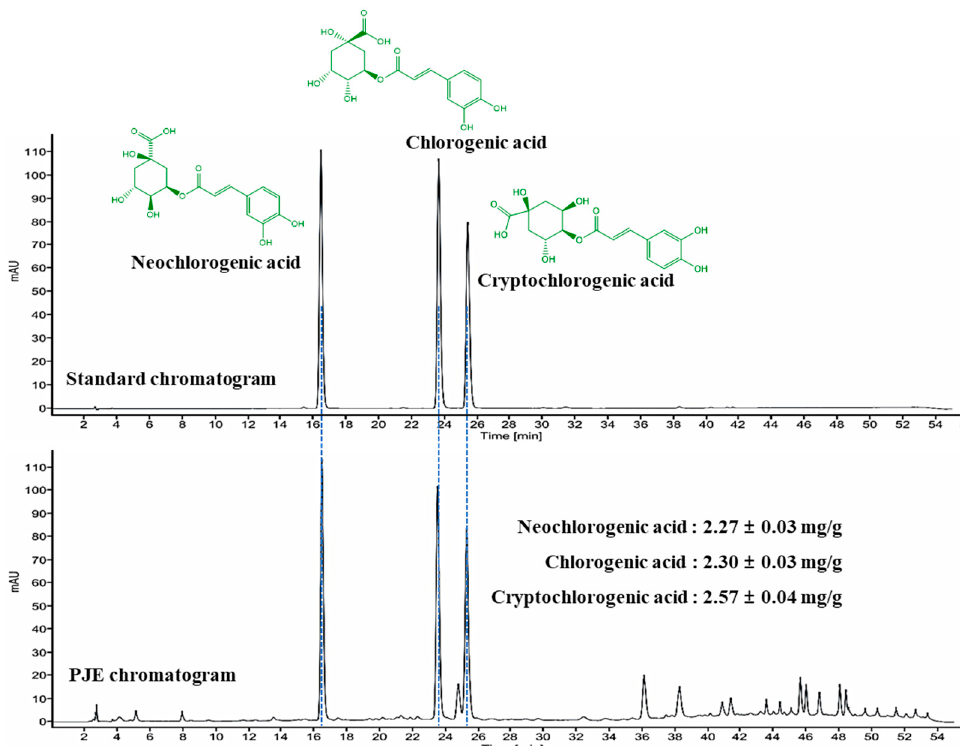
Figure 2. HPLC chromatograms of chlorogenic acid (CA), neochlorogenic acid (NCA) and cryptochlorogenic acid (CCA) as standard compounds and the P. japonicum Thunberg leaf extract (PJE).